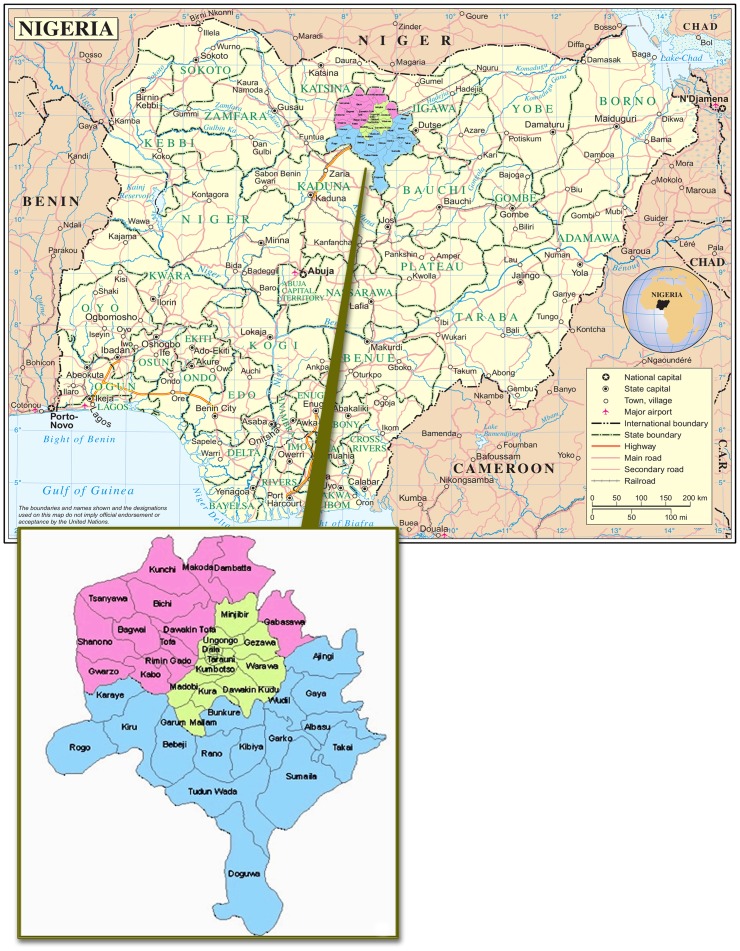
Kano State, Nigeria.